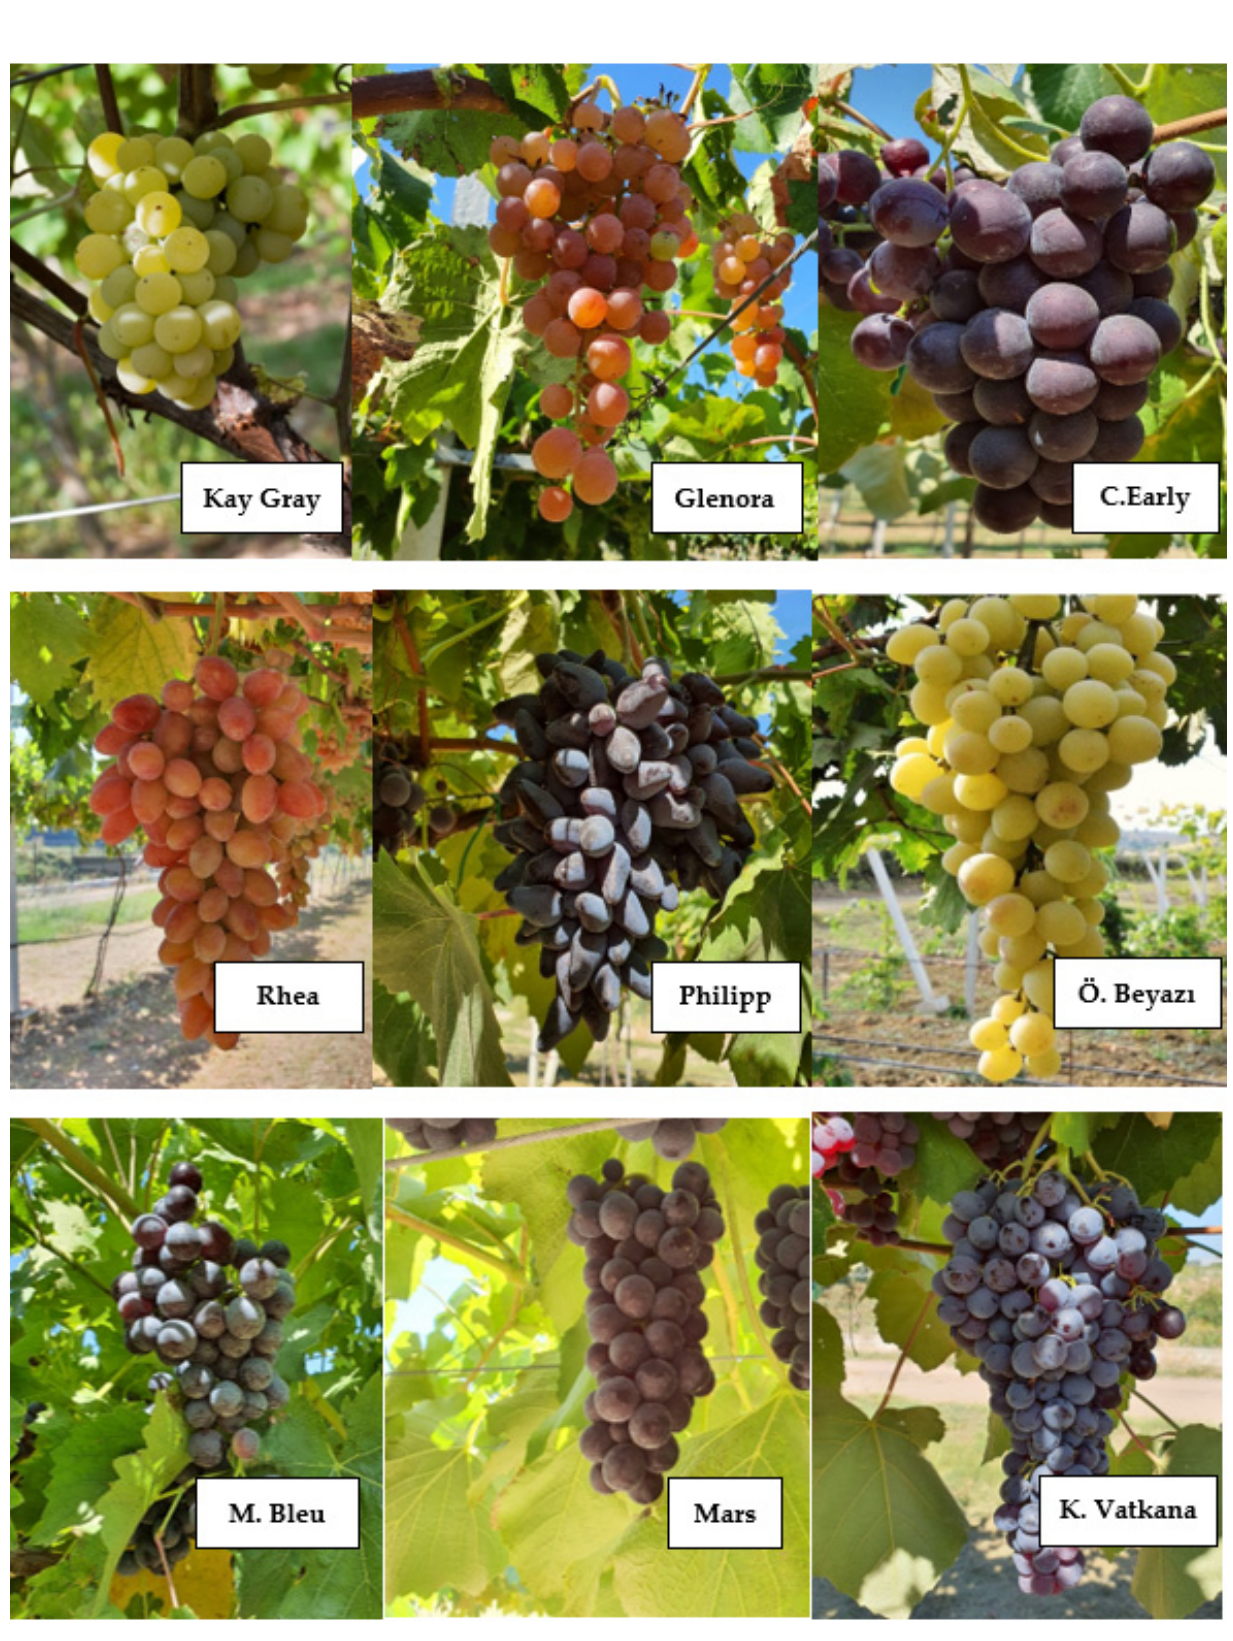
Figure 1. Bunches of grapes from the nine different grape cultivars used in this study.